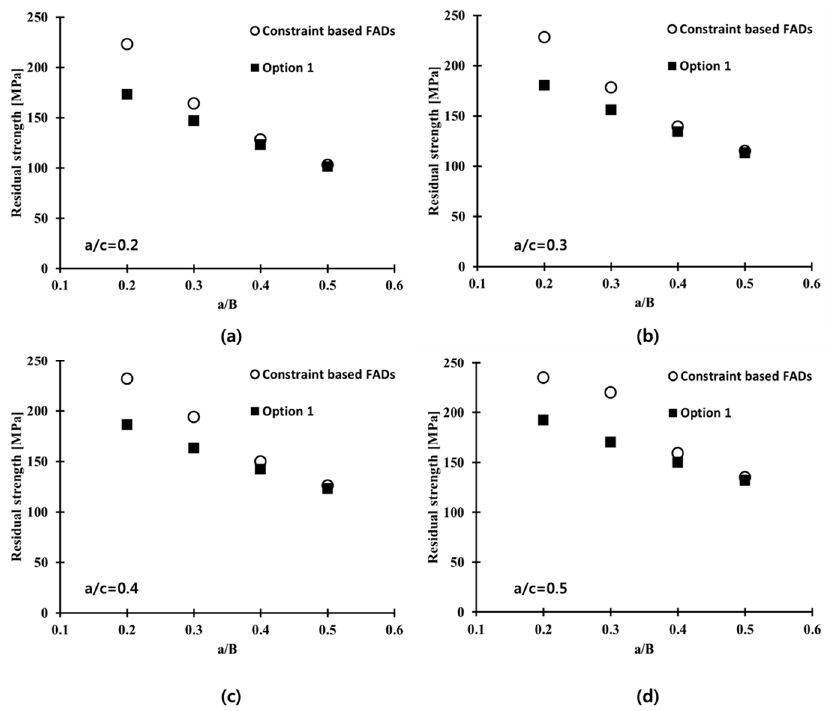
Figure 15. Comparison of the residual strength distribution for the welded plate of Al 5083-O with different crack configurations at cryogenic temperature ( a ) a/c = 0.2; ( b ) a/c = 0.3; ( c ) a/c = 0.4; and ( d ) a/c = 0.5.